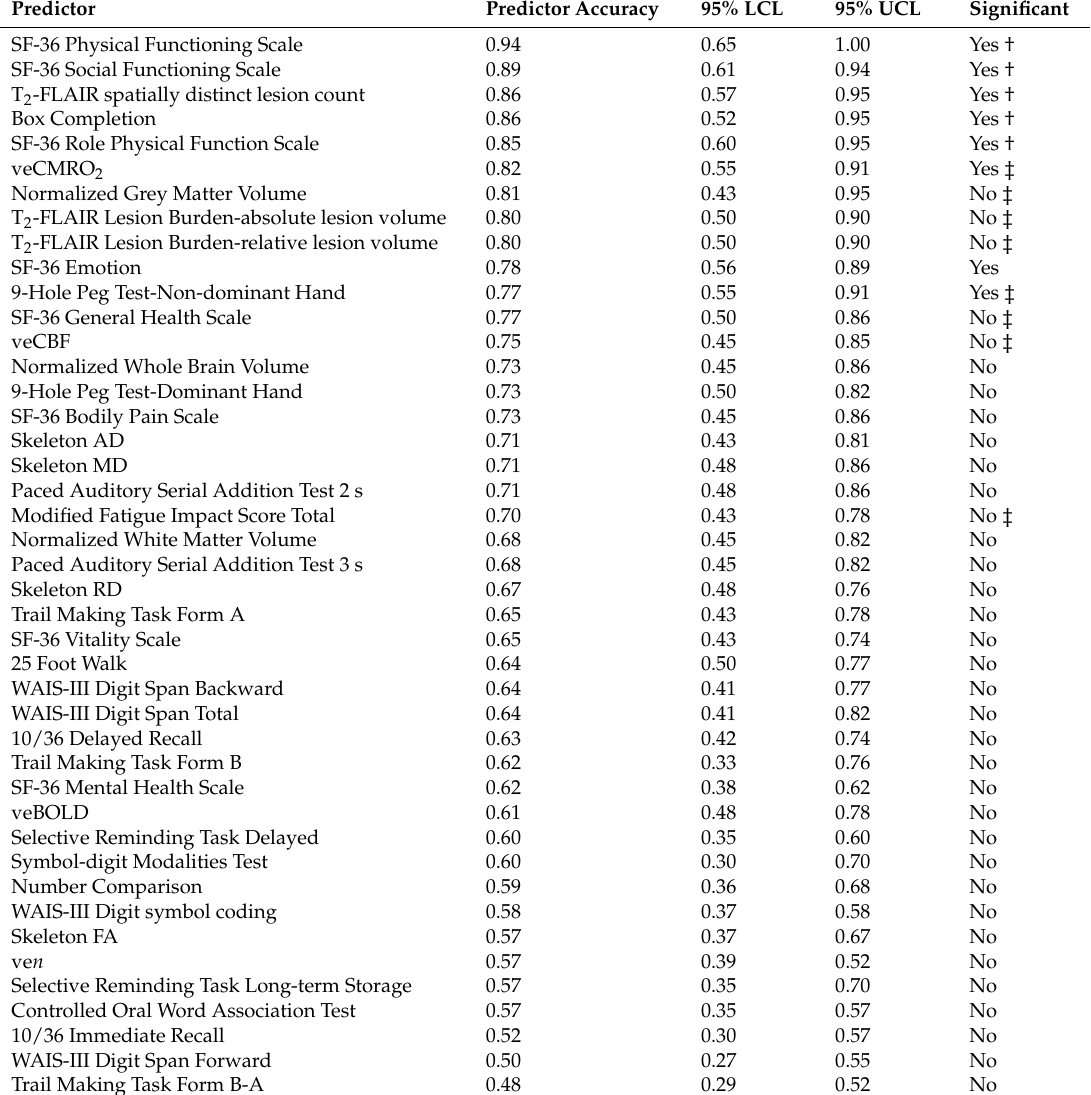
Table 4. Accuracy and 95% Confidence Limits of Within-Sample Classification Analyses. Predictor Predictor Accuracy 95% LCL SF-36 Physical Functioning